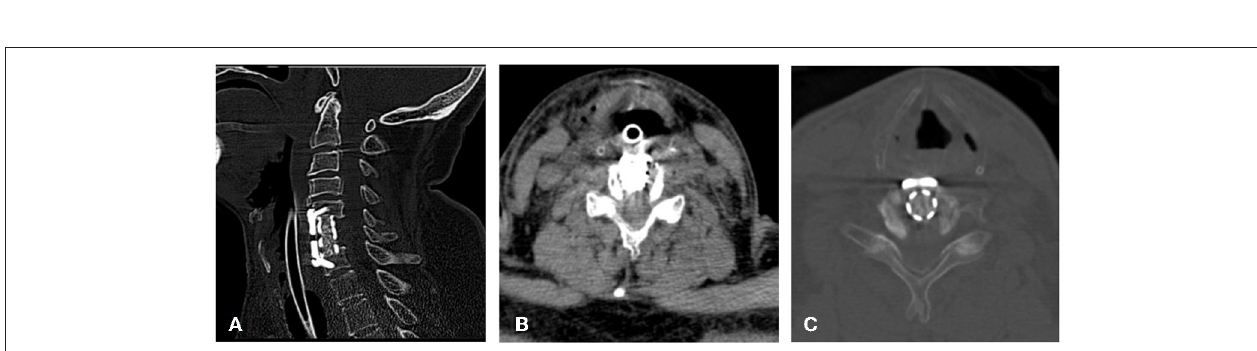
FIGURE 2 | Emergency CT revealed that normal implant location (A) and spinal canal morphology without any occupational manifestations in the spinal canal (B,C)